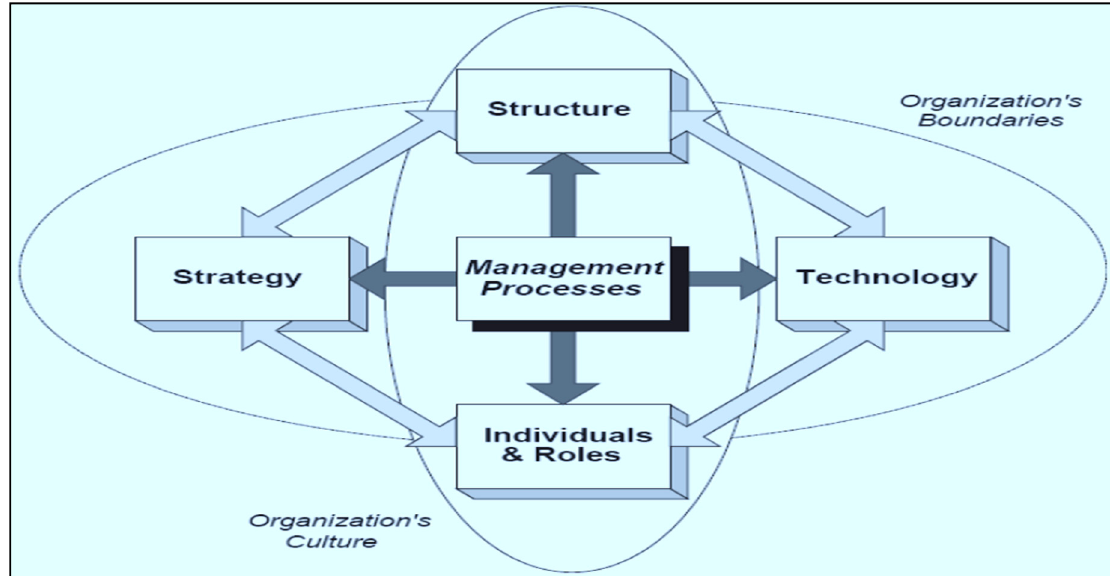
Figure 4. Massachusetts Institute of Technology Model. Source: Al-Majali (2011).